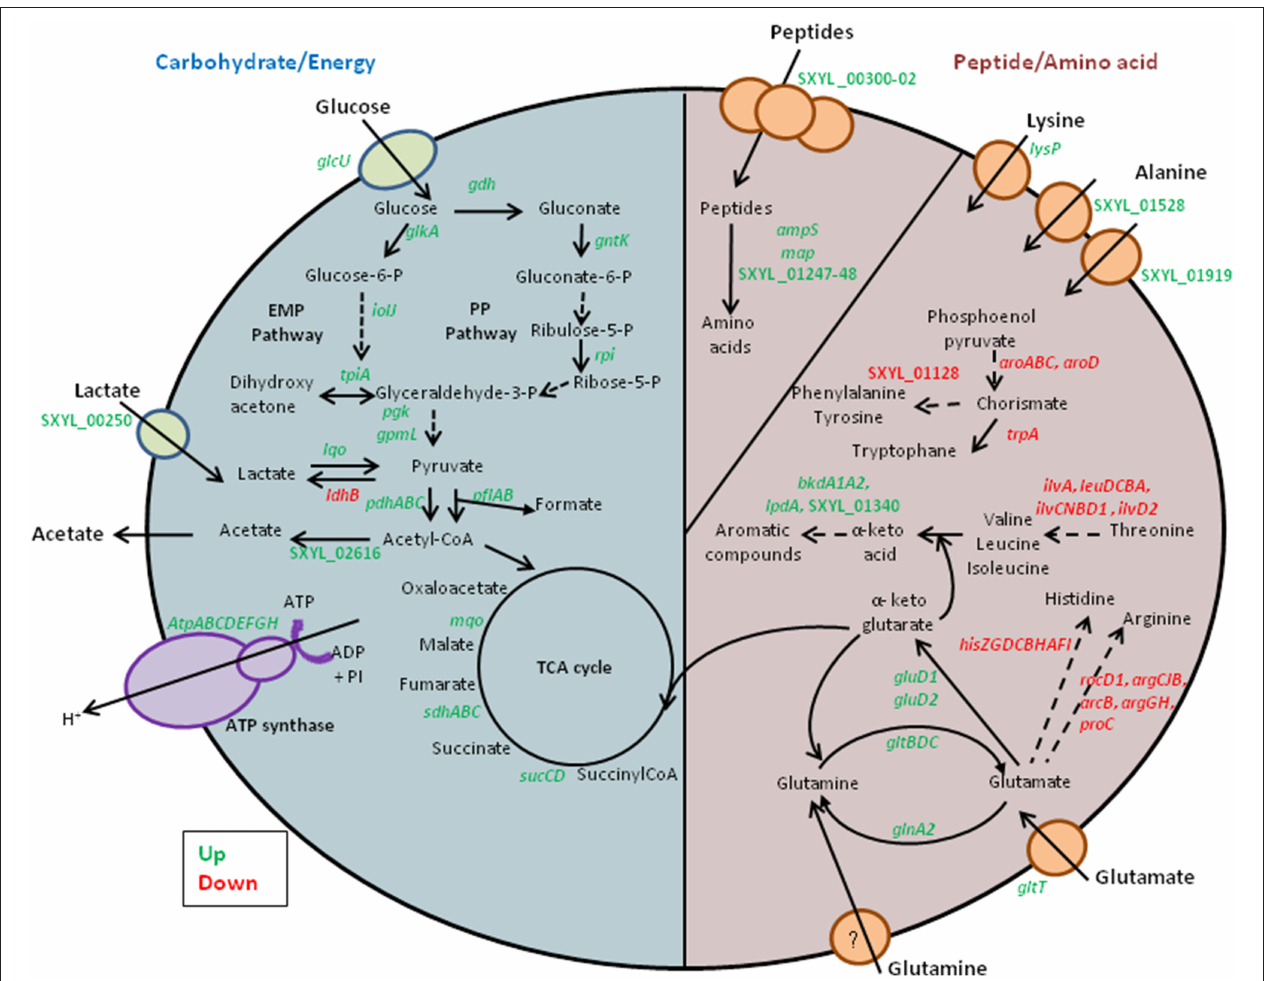
FIGURE 1 | Summary of the carbohydrate, peptide and amino acid metabolism in Staphylococcus xylosus in a meat